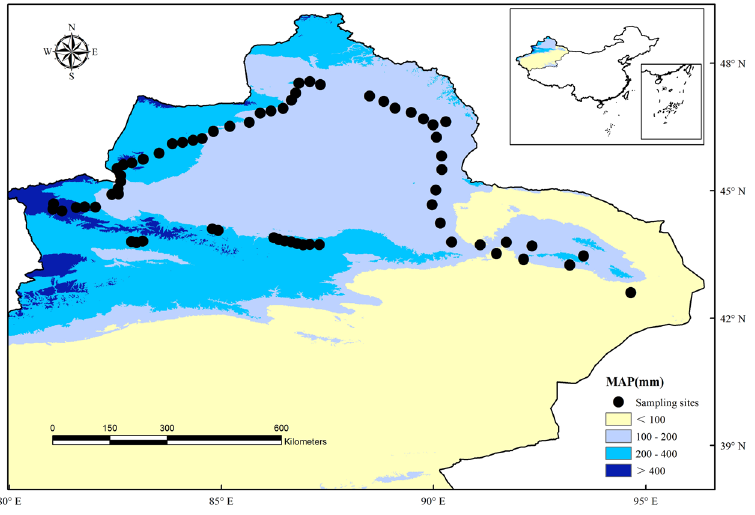
Figure 2. Mean annual precipitation (MAP) gradient map of the study area. Mean annual precipitation is shown as the background to the sites sampled in our study. The Mean annual precipitation dataset was provided by the WorldClim global climate database (http://www.worldclim.org), and the maps were created using ArcGIS 10